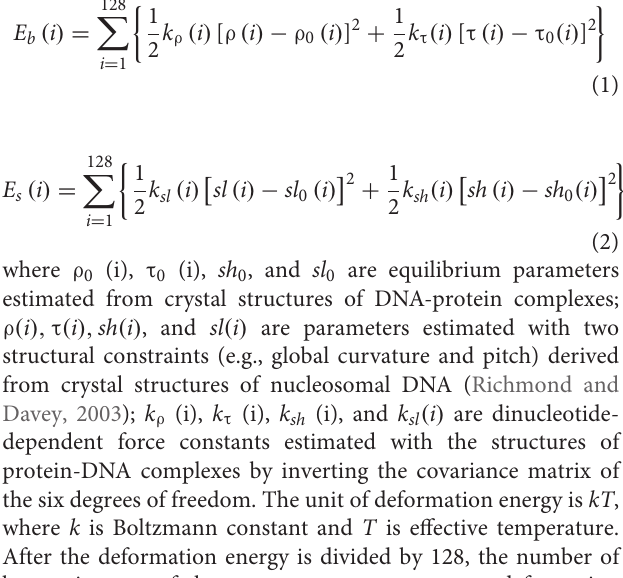
Frontiers in Cell and Developmental Biology |